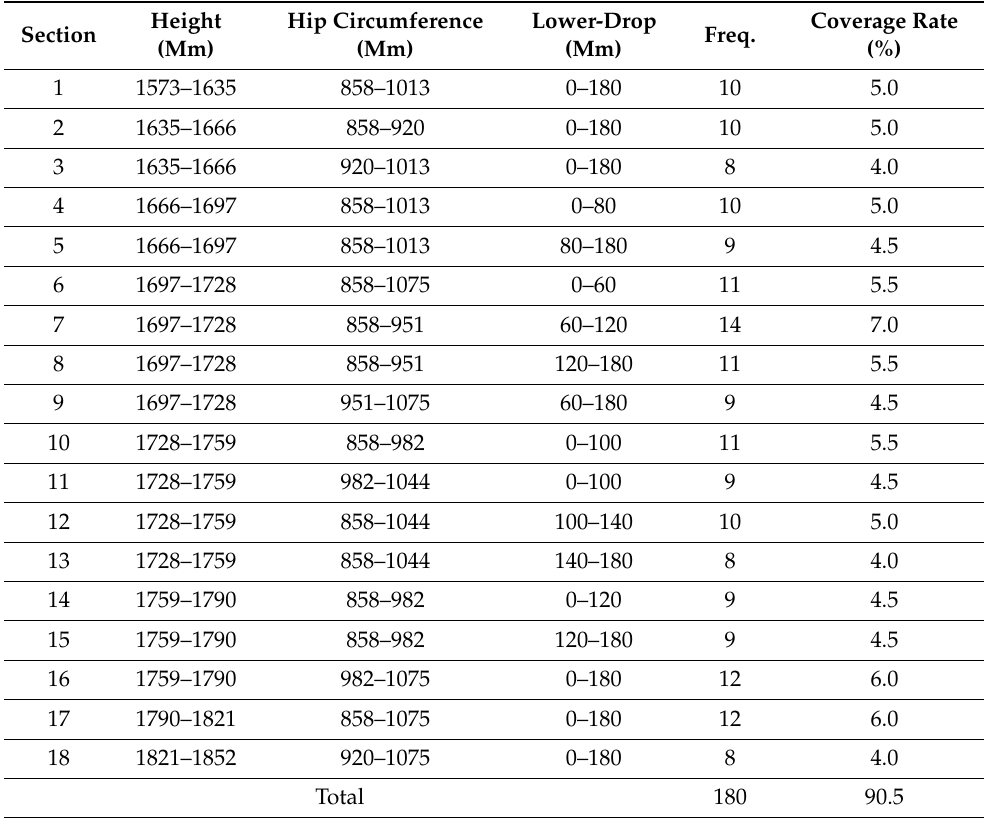
Table 8. Results of secondary cross-tabulation analysis.